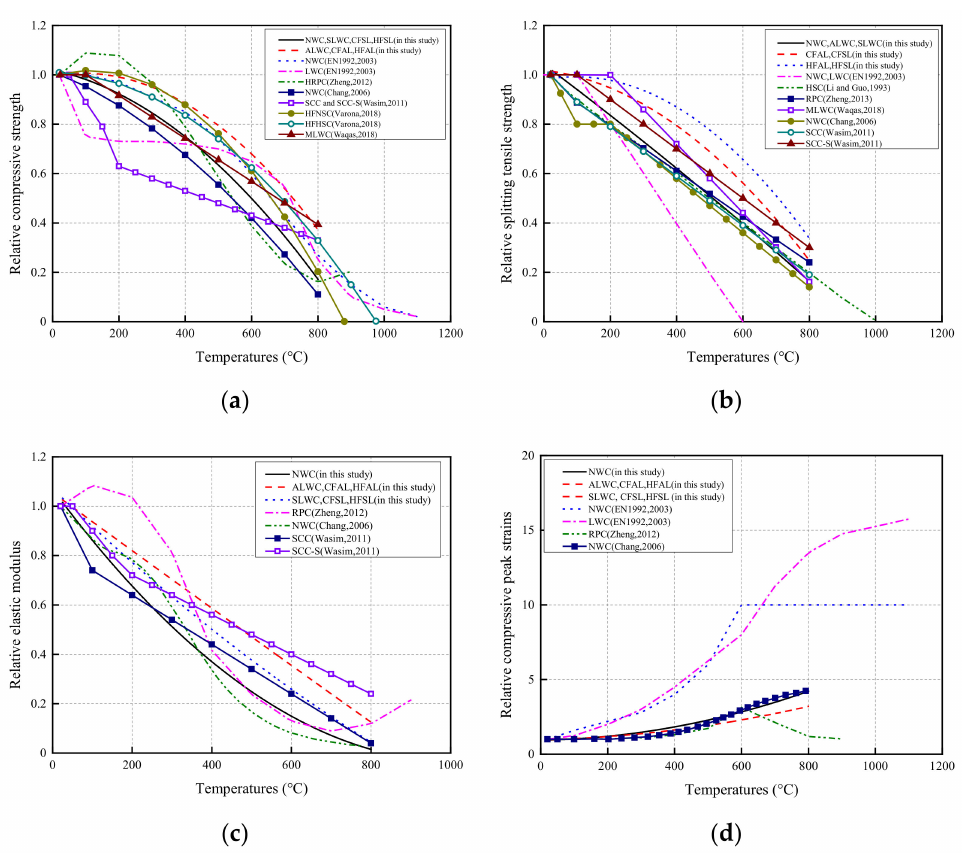
Figure 14. Evolution of the residual mechanical characteristics under high temperatures: ( a ) com- pressive strength; ( b ) splitting tensile strength; ( c ) elastic modulus; ( d ) compressive peak